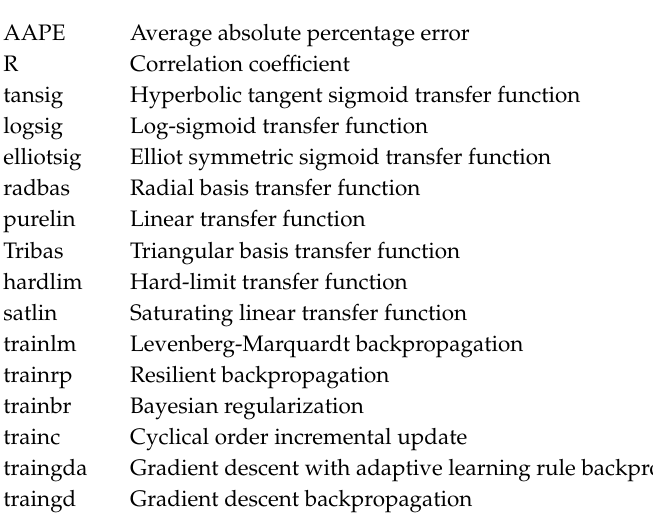
Table A1. Extracted constants for estimating the normalized Y p